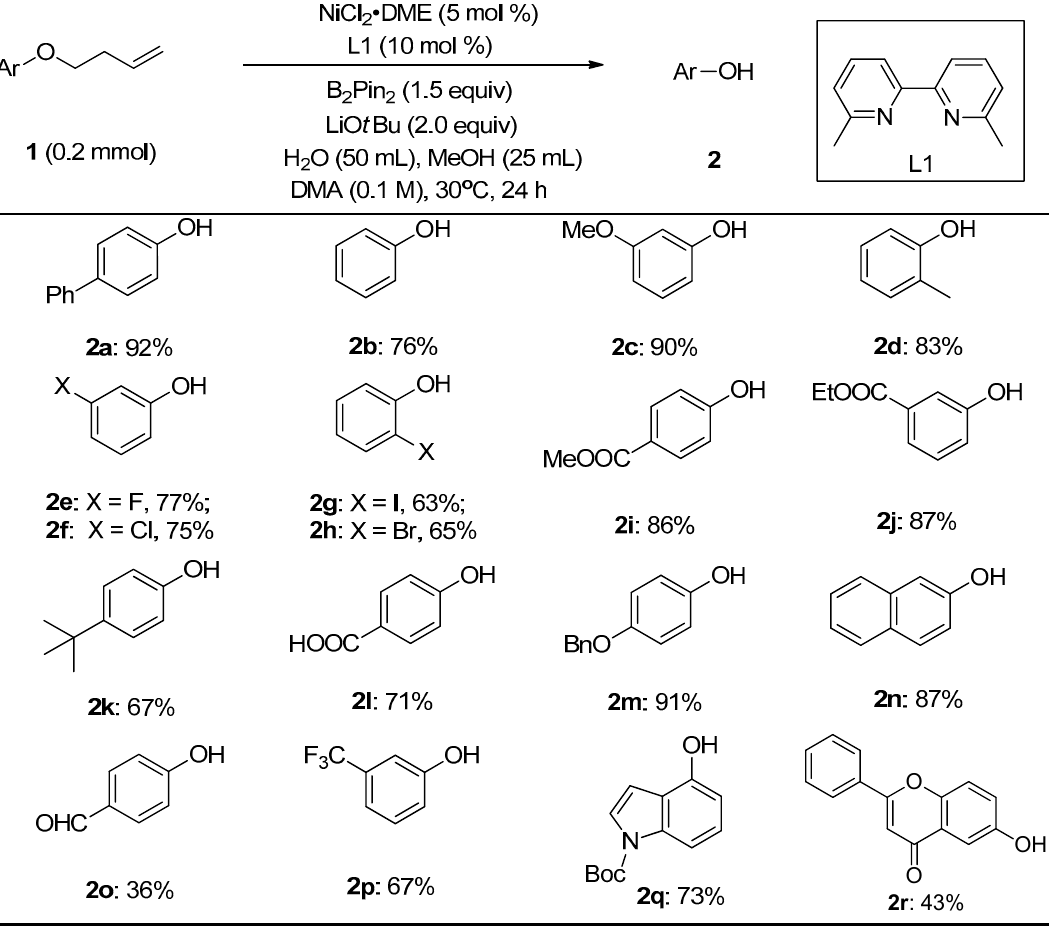
Table 3. Scope of alkene protecting groups. Conditions: a Without Ni catalyst and ligand. See Supplementary Materials for details .